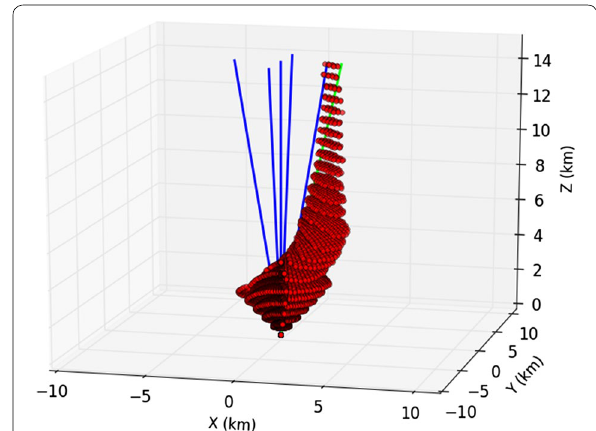
Fig. 3 An example of the 3-D projection of the ray-tracing results. The conditions are the same as in Fig. 2, but the shading distance is limited to 60 m. Five blue lines indicate the vertical and four oblique antenna beams at the 10° zenith angle and the green line at (90°, 13°)